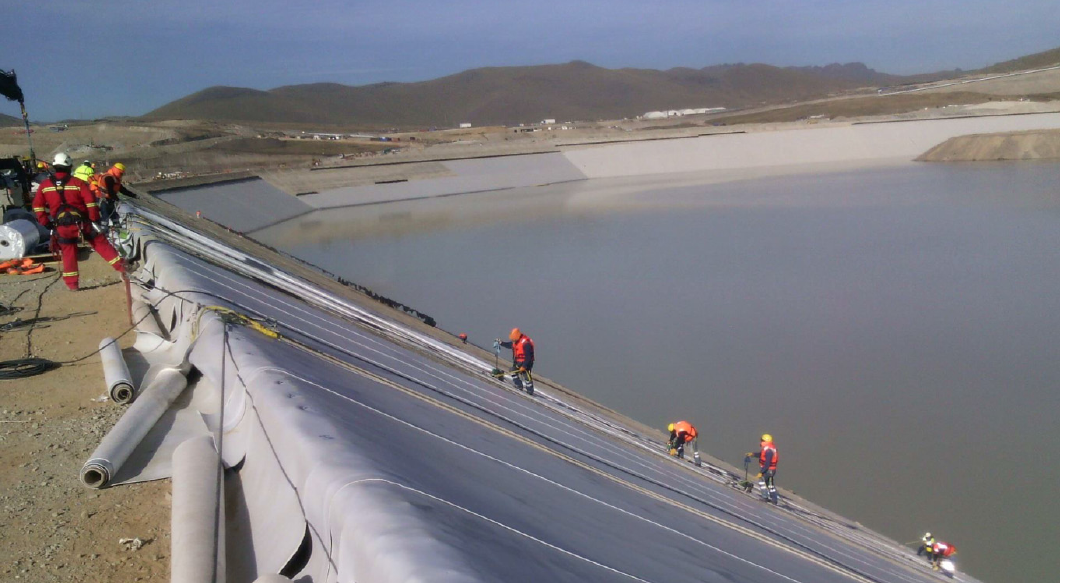
Figure 13. Geomembrane installation—typical construction activities, 2H:1V dam